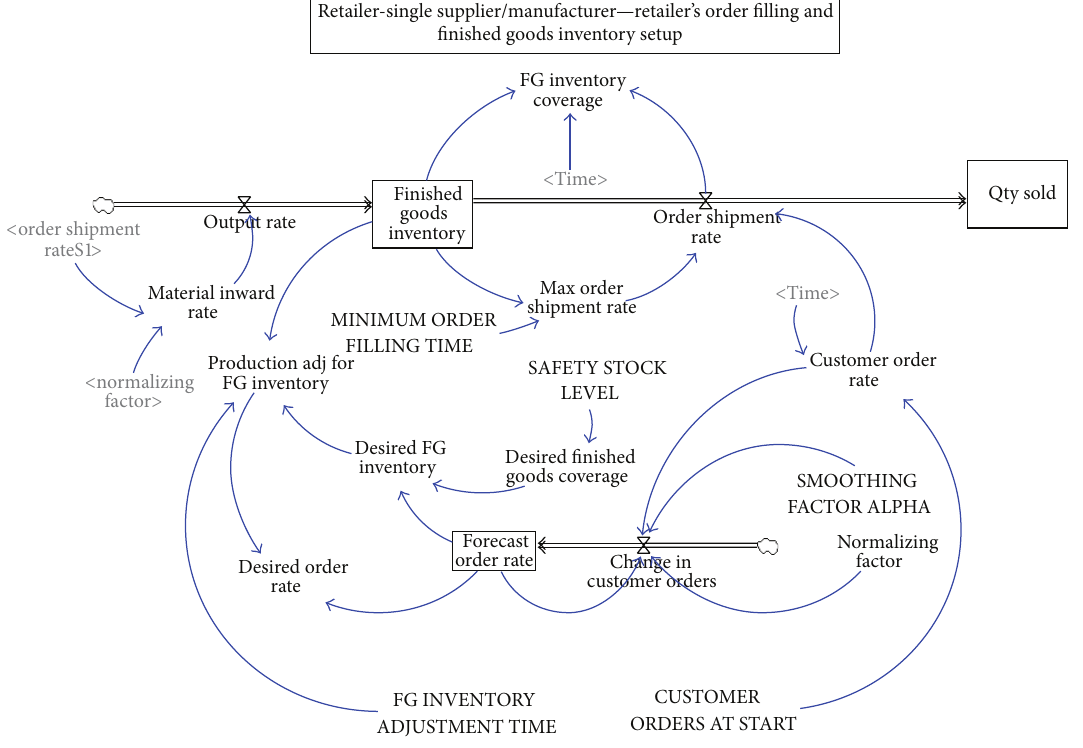
Figure 1: Retailers order-filling process and inventory management.